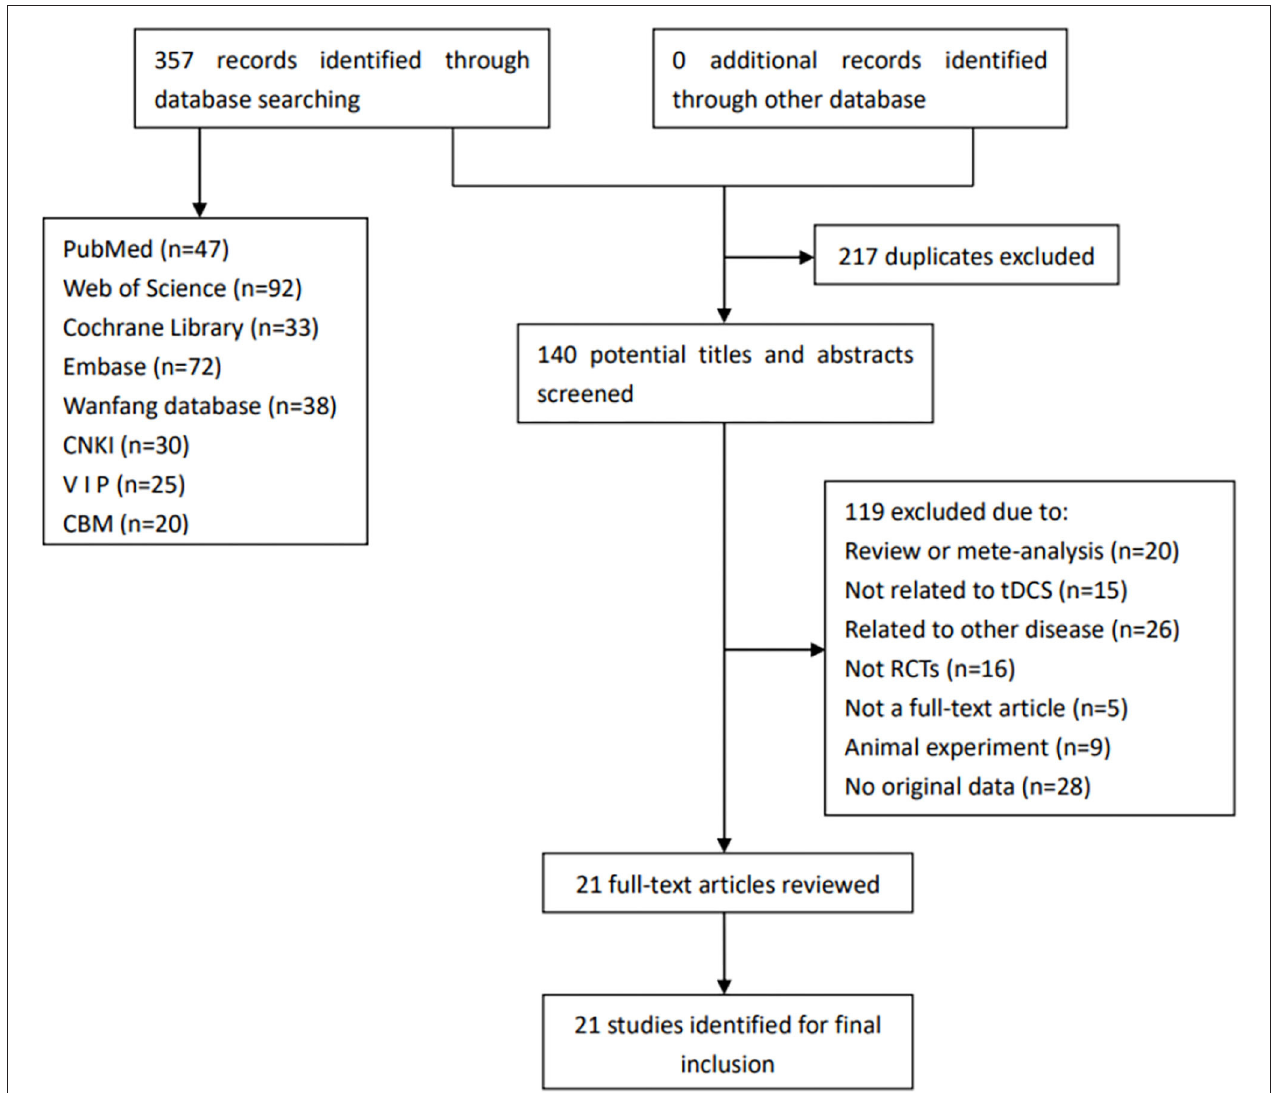
FIGURE 1 | Flow diagram for the selection of the included studies. CBM, China Biology Medicine; CNKI, China National Knowledge Infrastructure; RCTs, randomized controlled trials; tDCS, transcranial direct current stimulation; VIP, China Science and Technology Journal Database.